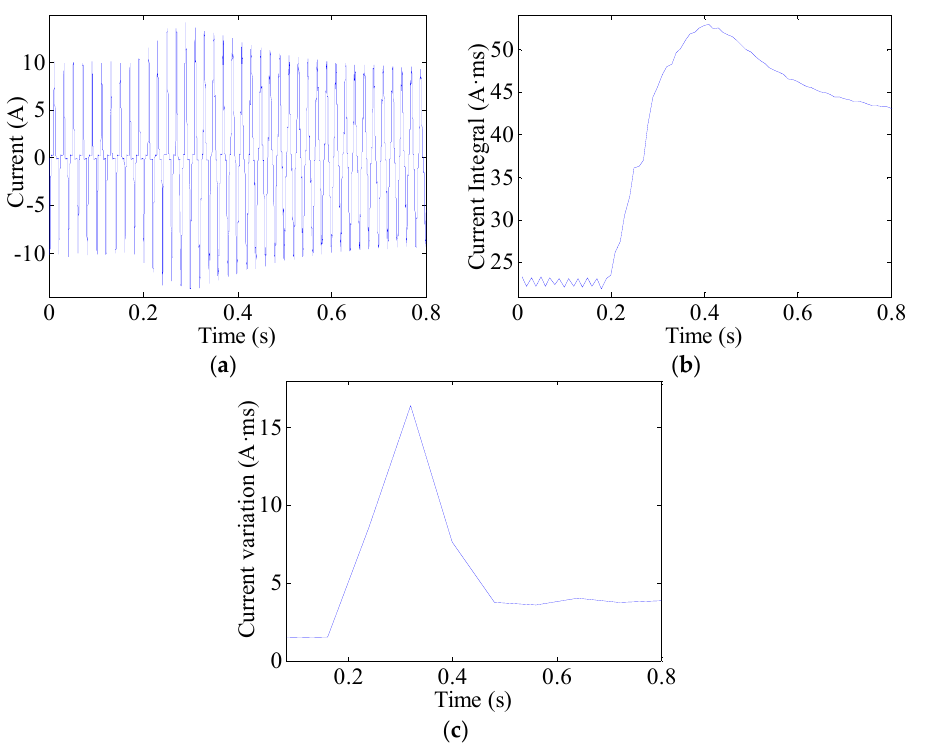
Figure 17. Transient process analysis of the vacuum cleaner: ( a ) current waves; ( b ) current periodic integrals; ( c ) current variations.